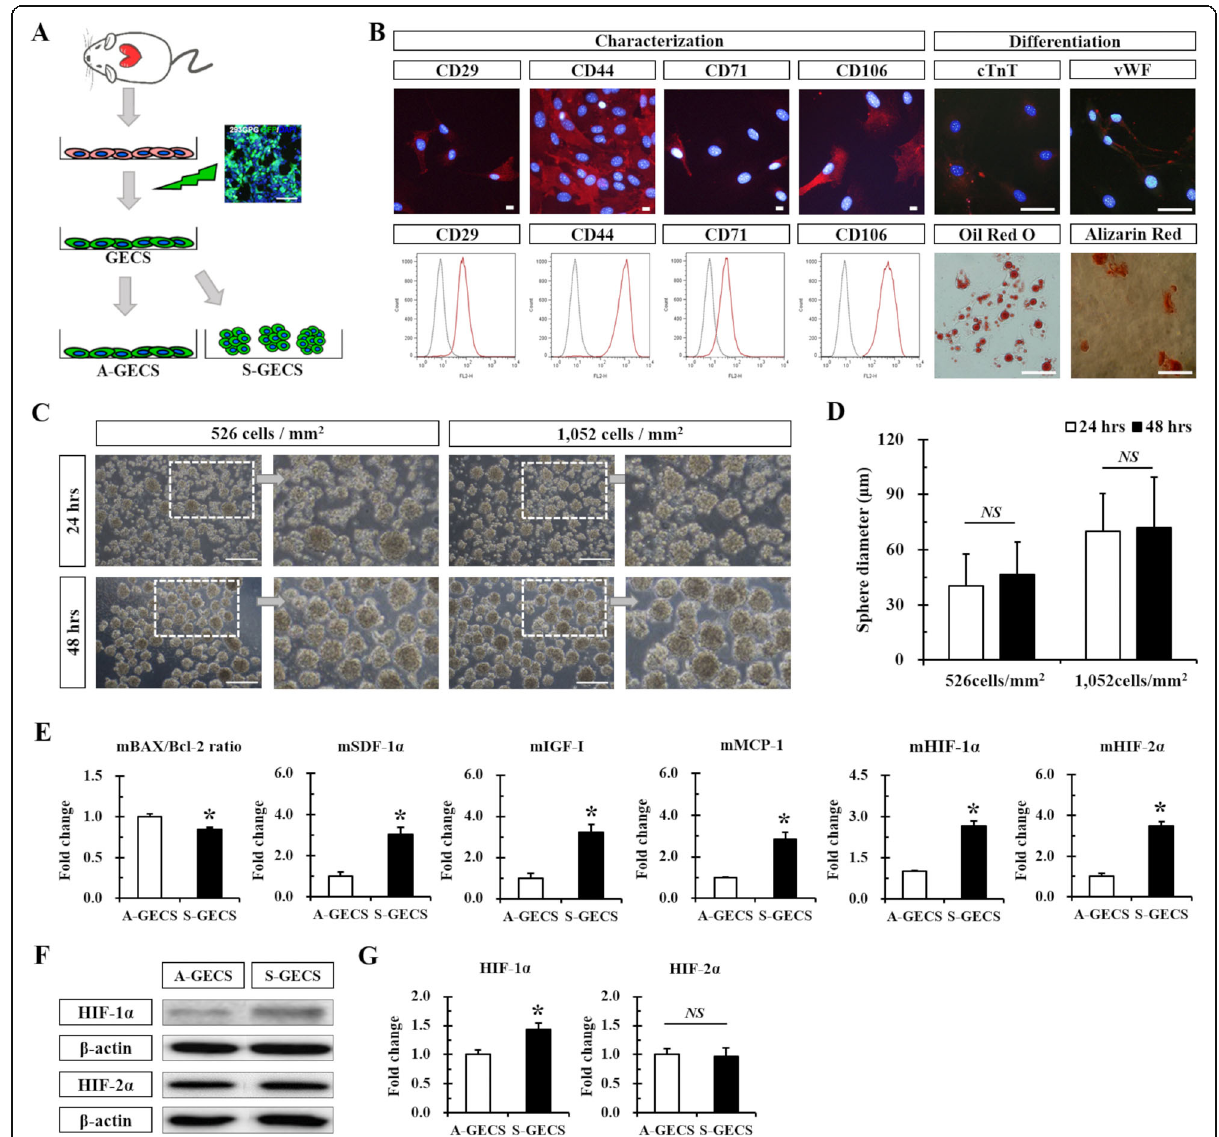
Fig. 1 GECS generation and characterization. a Schematic diagram of GECS obtained from hTERT-immortalized Sca-1+ CSC lines. b Representative immunofluorescence images and flow cytometry of GECS. c Representative phase-contrast images of S-GECS produced on Poly-HEMA-coated plates 24 and 48 h after seeding. d Time-dependent increase in S-GECS diameter. n = 58 in each group. e Quantitative RT-PCR analysis of apoptotic, hypoxic, and growth factors in A-GECS and S-GECS for 48 h, each in triplicate. * p < 0.05 vs. A-GECS. f and g Western blot and quantification of HIF-1 α and HIF-2 α expression in A-GECS and S-GECS, each in triplicate. * p < 0.05 vs. A-GECS. All results are representative;